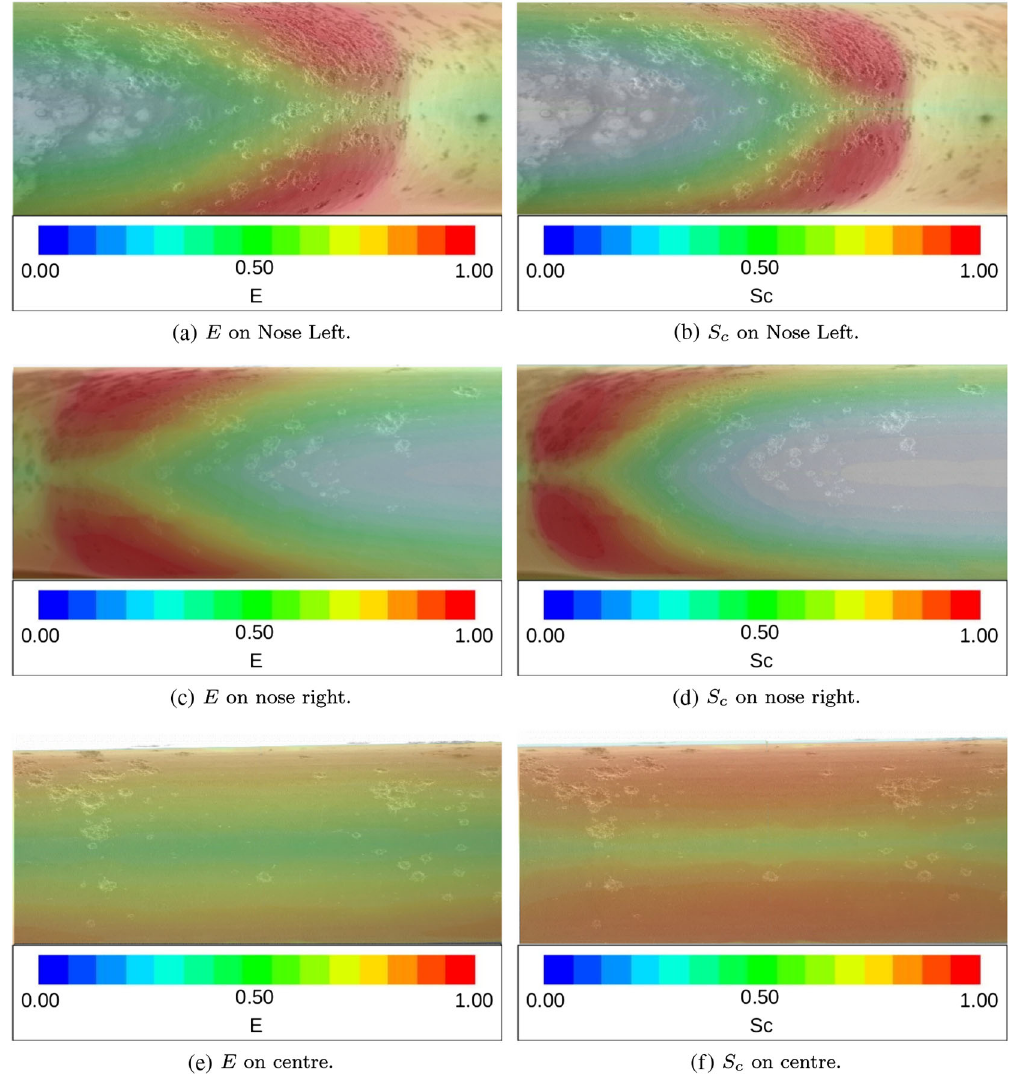
FIG. 18. Scanning electron microscope images of various segments along the first iris. Overlaid is a field map of the surface electric field for a comparison of the breakdown location to the field strength. The location of each scan is described in Fig.